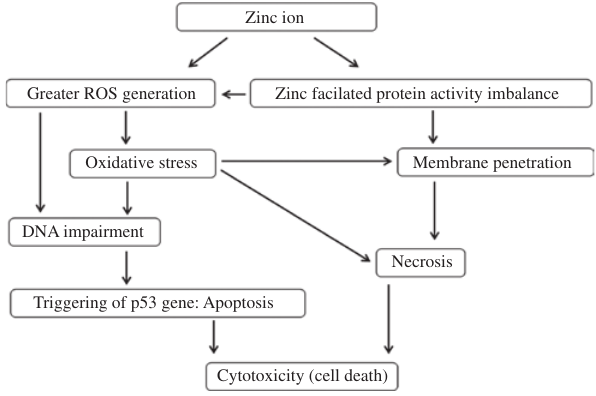
Figure 9: A chart depiction of the whole cytotoxicity of zinc NPs, causing cell